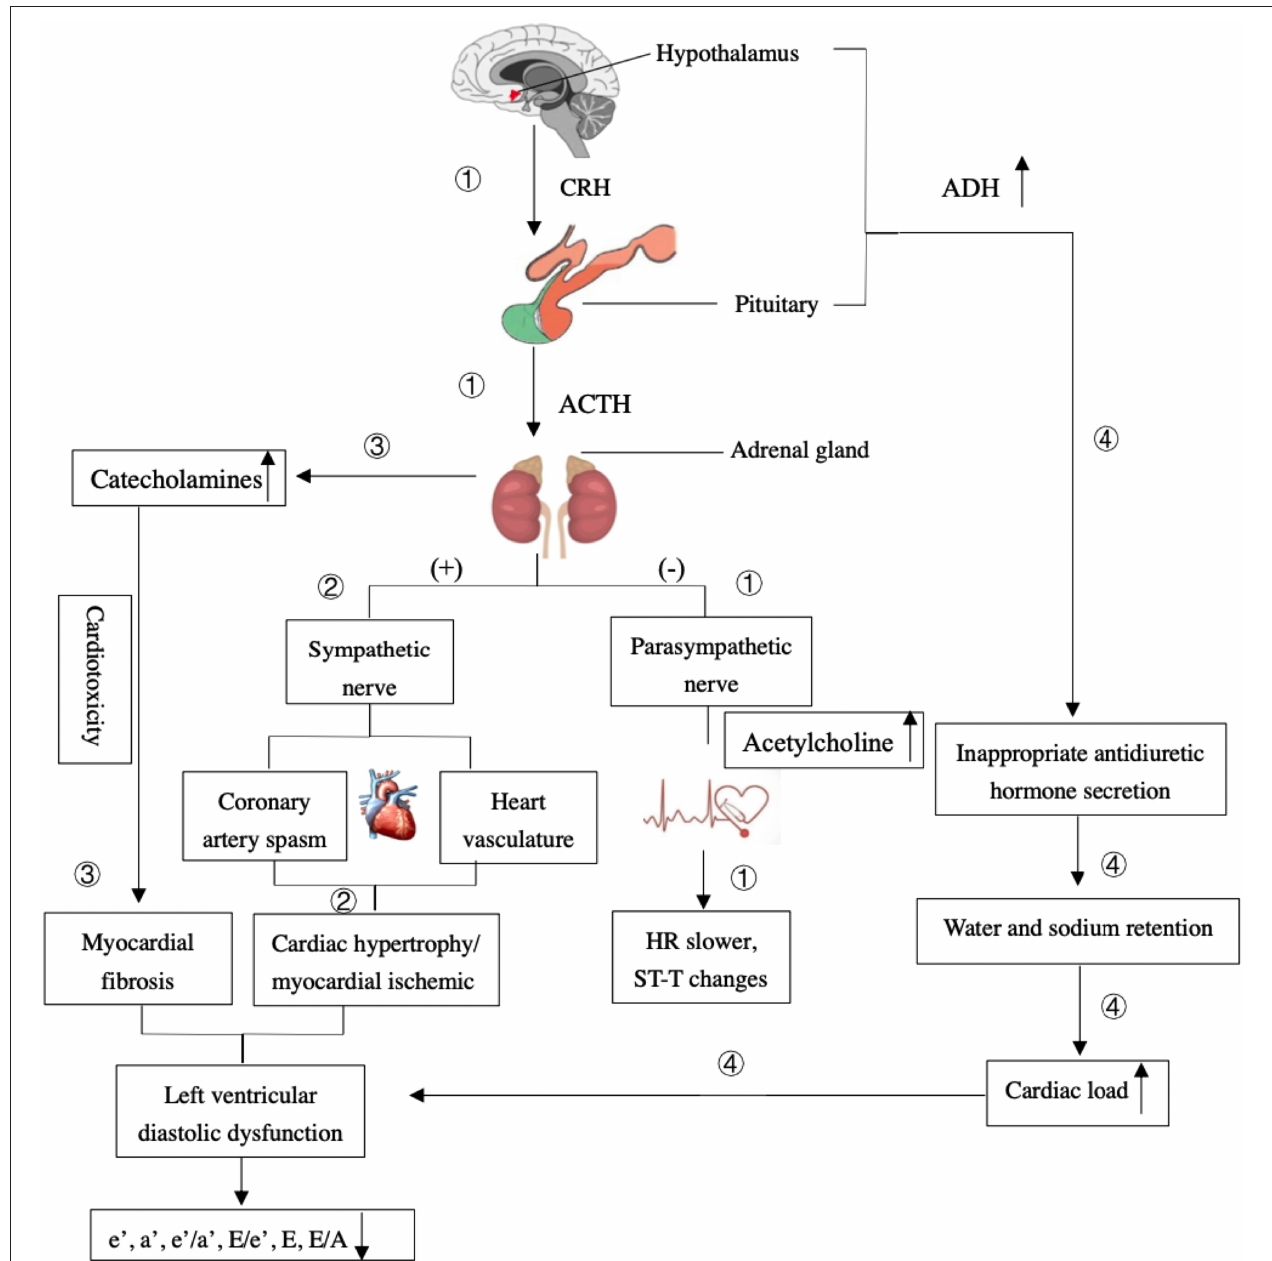
FIGURE 6 | The mechanism of the effects of ischemic stroke on the left ventricular diastolic dysfunction. ‹ The HPA regions are damaged from an ischemic stroke, it could stimulate the parasympathetic nerve to have a negative effect on the cardiac electrical activity and result in the heart rate (HR) slower and ST-T changes. › A strong stress response would result in the release of catecholamines, which in turn promote sympathetic and minimize parasympathetic activities to intensify constriction of the heart vasculature, coronary artery spasm, and cause cardiac hypertrophy or myocardial ischemia. fi Long-term elevated levels of catecholamines can lead to cardiotoxicity and generate transient fibrosis and left ventricular diastolic dysfunction. fl The excessive release of antidiuretic hormone (ADH) caused by damaged hypothalamus and the syndrome of inappropriate antidiuretic hormone secretion occurs. It causes water and sodium retention, which translates to an increase in cardiac load and left ventricular diastolic